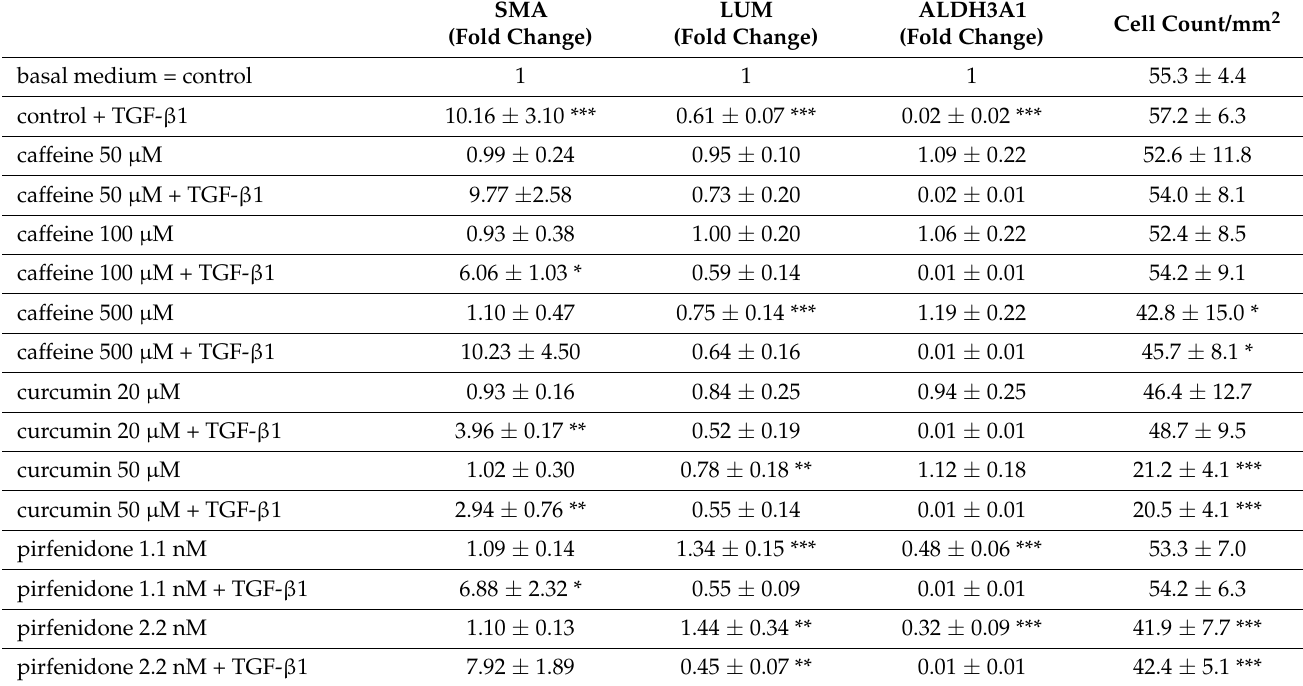
Table 1. Cell count and real-time polymerase chain reaction (RT-PCR) results for aldehyde dehy- drogenase family 3 member A1 (ALDH3A1), lumican (LUM) and α -smooth muscle actin (SMA) in activated corneal stromal keratocytes (aCSK) after incubation for 48 h in media containing the indicated concentrations of the antifibrotic molecules (AFM) caffeine, curcumin and pirfenidone, with and without the profibrotic cytokine 10 ng/mL TGF- β 1. Relative fold changes were calculated in comparison to the control group. Significant differences between groups are indicated by * p ≤